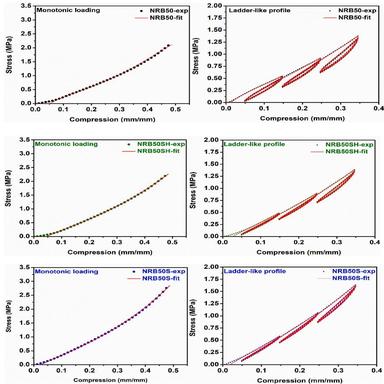
Agreement between experimental and model values for both loading paths and all three material systems.